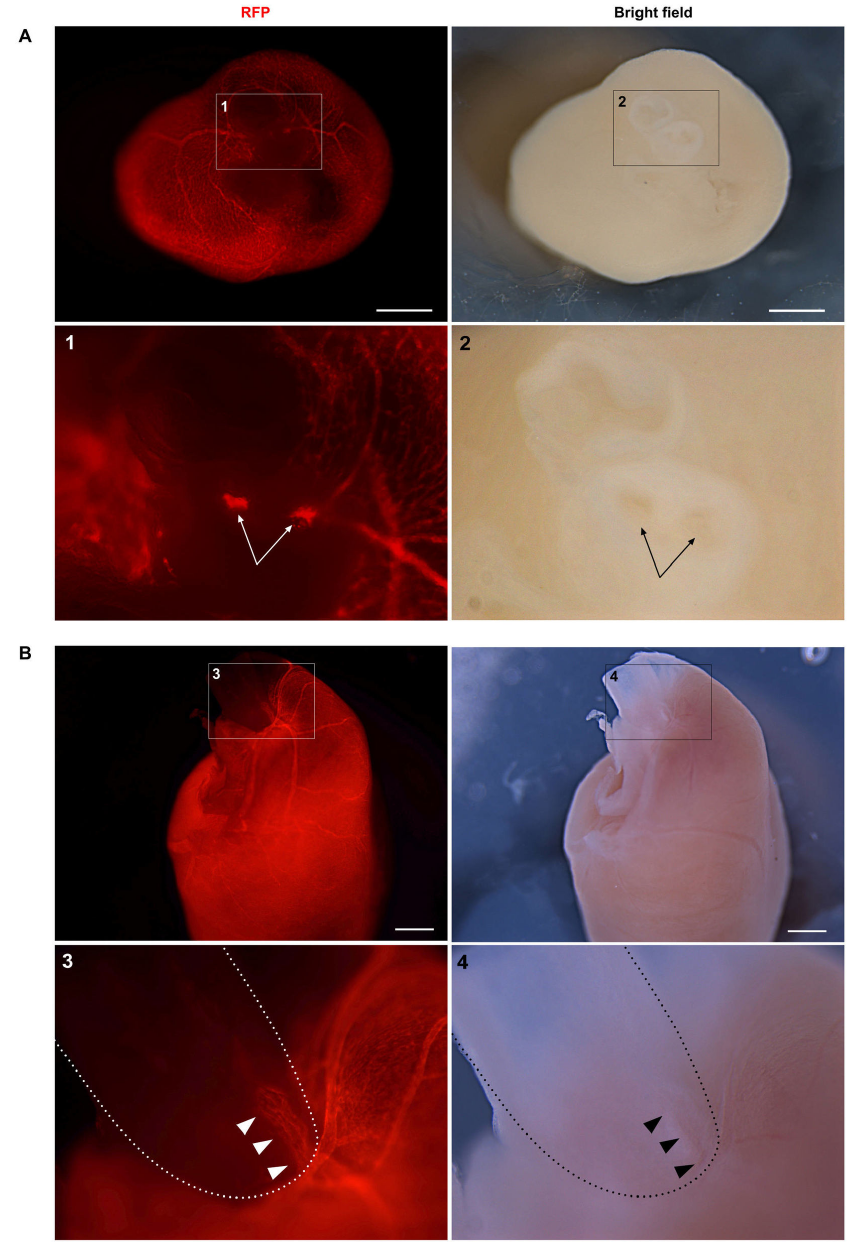
Figure 4. Coronary orifice forms by recruiting coronary vascular endothelial cells into aorta. ( A ) Whole mount pictures of E18.5 AplnCreERT2/+;Rosa26RFP/+ heart under fluorescence or bright field. Arrows indicate the left and right coronary orifice inside aorta. The zoomed out pictures are taken from base, and the magnified pictures are viewed from inside of aorta. Tamoxifen was administered at E10.5. ( B ) Whole mount pictures of P7 AplnCreERT2/+;Rosa26RFP/+ heart under fluorescence or bright field. Arrowheads indicate RFP+ tubular structure representing coronary artery stem communicating with the aortic lumen (dotted line). The zoomed out and magnified pictures are viewed from right side of the heart and great vessels. Tamoxifen was injected at E10.5. Bar = 500 um. doi: 10.1371/journal.pone.0080857.g004 PLOS ONE |